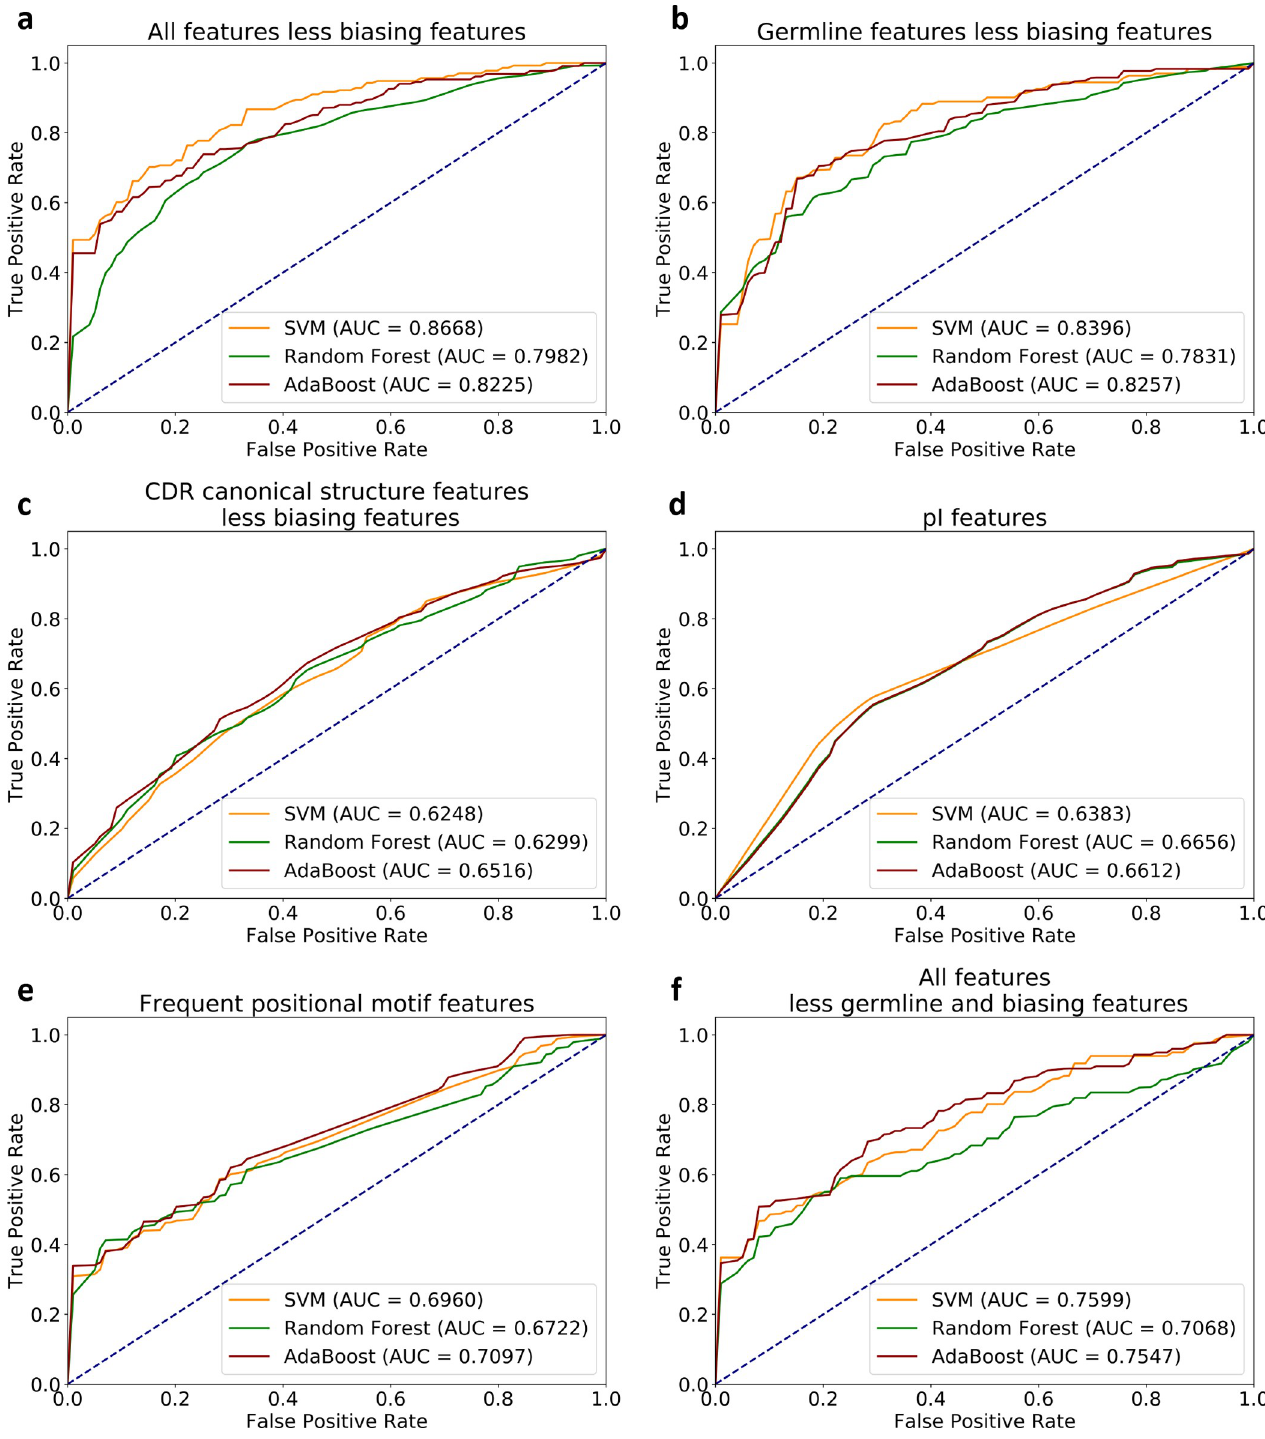
Fig 3. Area Under ROC Curves (AUC) for classification of MMP-targeting vs PDB-reference sets using SVM, random forest AdaBoost algorithms, while excluding biasing features and their associated features. (a) AUC based on all included features, (b) AUC based on germline features, (c) AUC based on CDR canonical structure features, (d) AUC based on pI features, (e) AUC based on frequent positional motifs features, (f) AUC based on all features excluding all germline features and associated CDR canonical structure features.